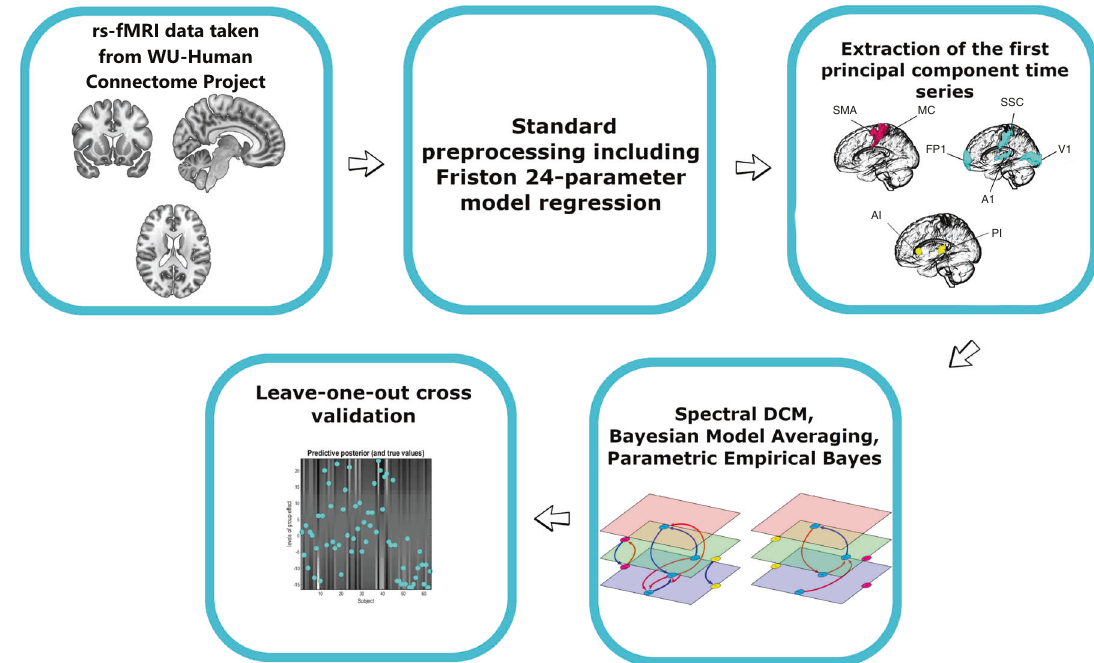
Fig. 1 Analysis pipeline. Outline of the analysis pipeline, see Materials and